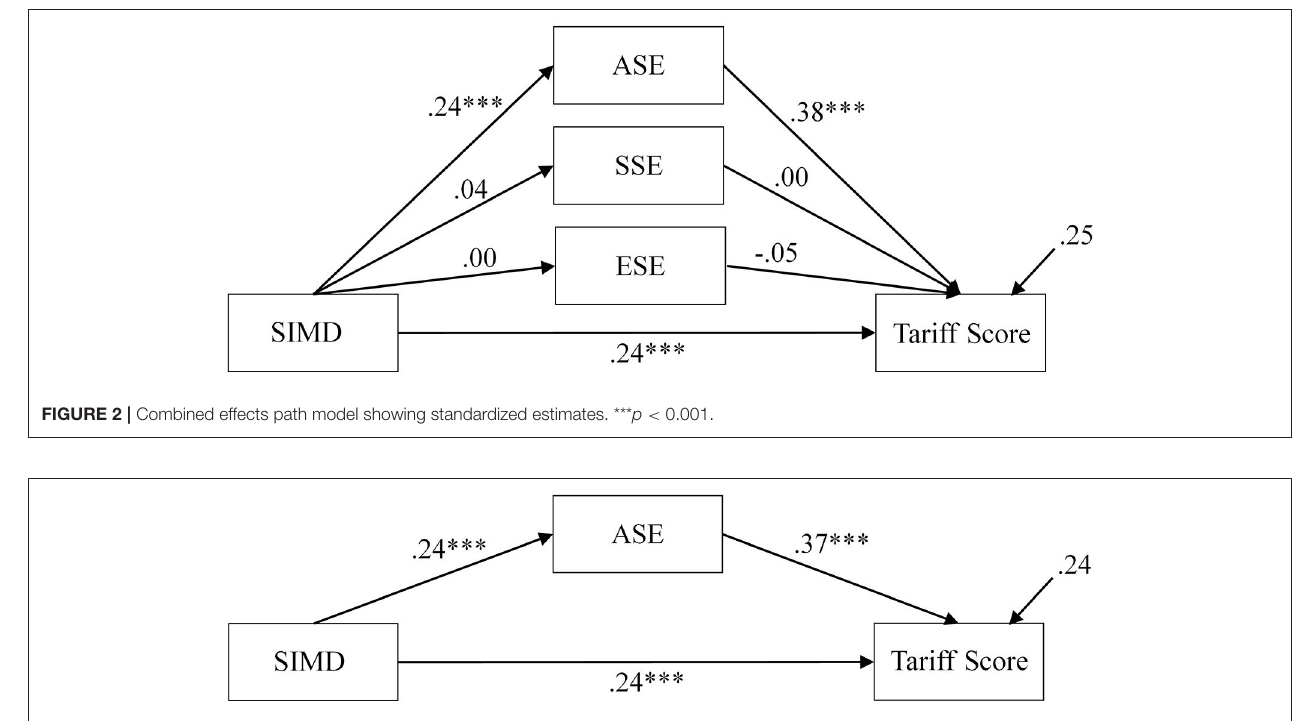
FIGURE 3 | Path model for simplified combined effects model showing standardized estimates. *** p <